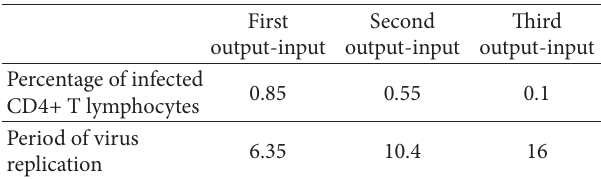
Table 4: Outputs of the FRBS and input of CA used in